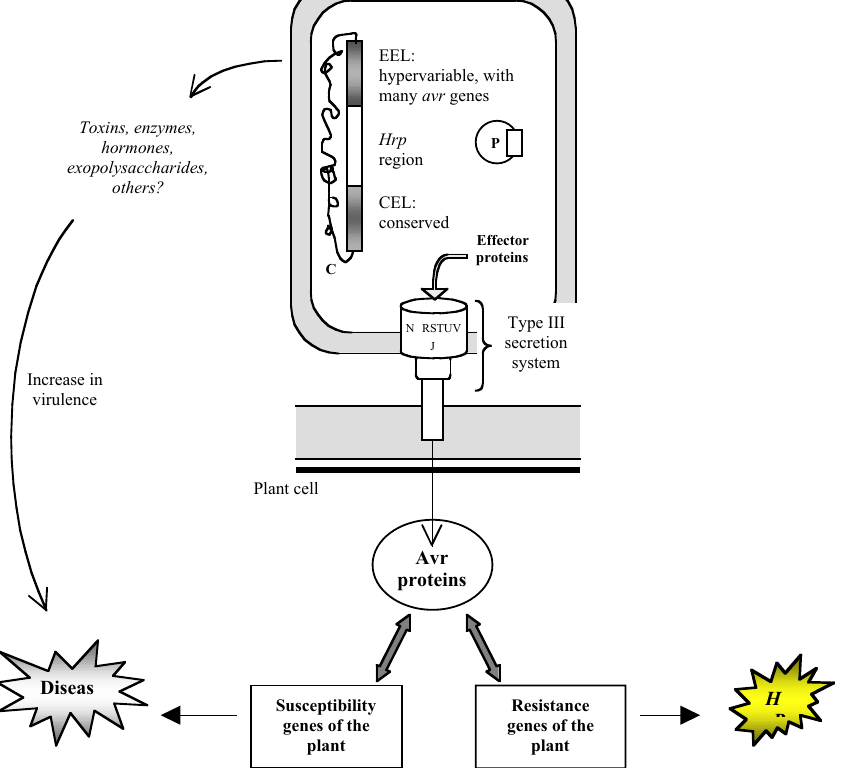
Fig. 1. Putative model to explain bacterial pathogenicity. The Hrp type III secretion system delivers effector pro- teins (the products of avirulence and virulence genes) into the plant cell; their specific interaction with plant resist- ance genes and with putative susceptibility genes will determine the production of an HR or disease, and the amount of disease produced. Some other bacterial factors, such as toxins or enzymes, can also participate to increase the virulence. EEL is the Exchangeable Effector Locus and CEL is the Conserved Effector Locus. C, chromosome; P,